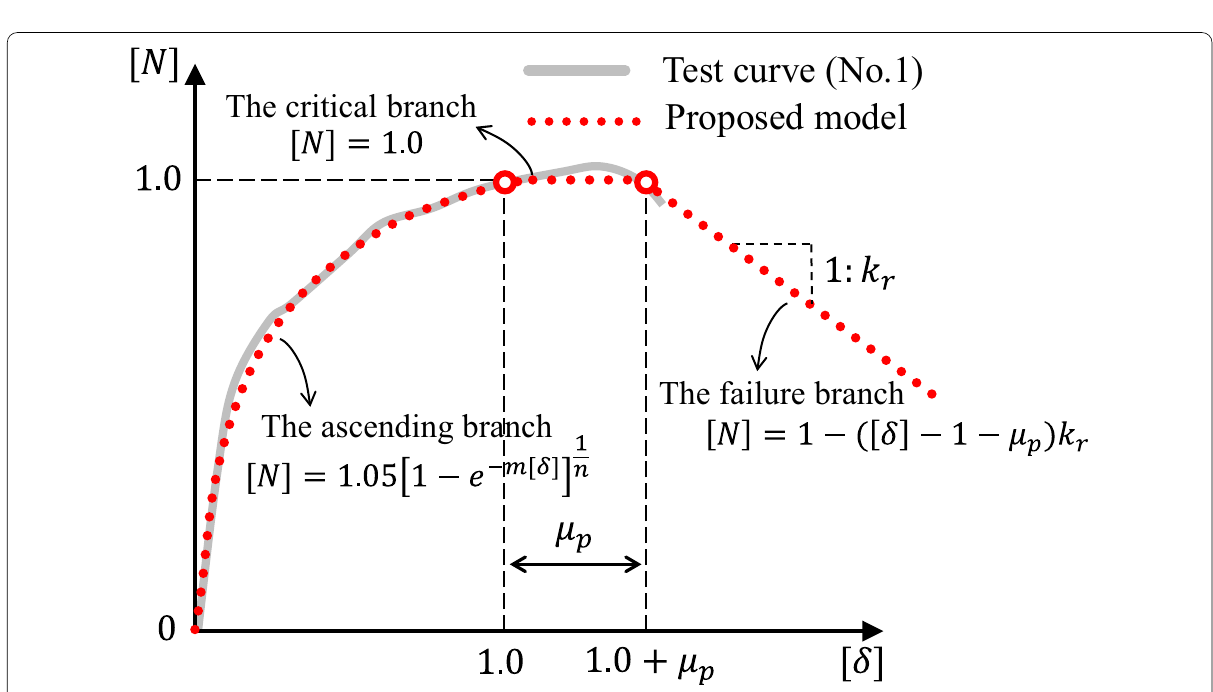
Fig. 18 Mathematical expression of the normalized load–deformation